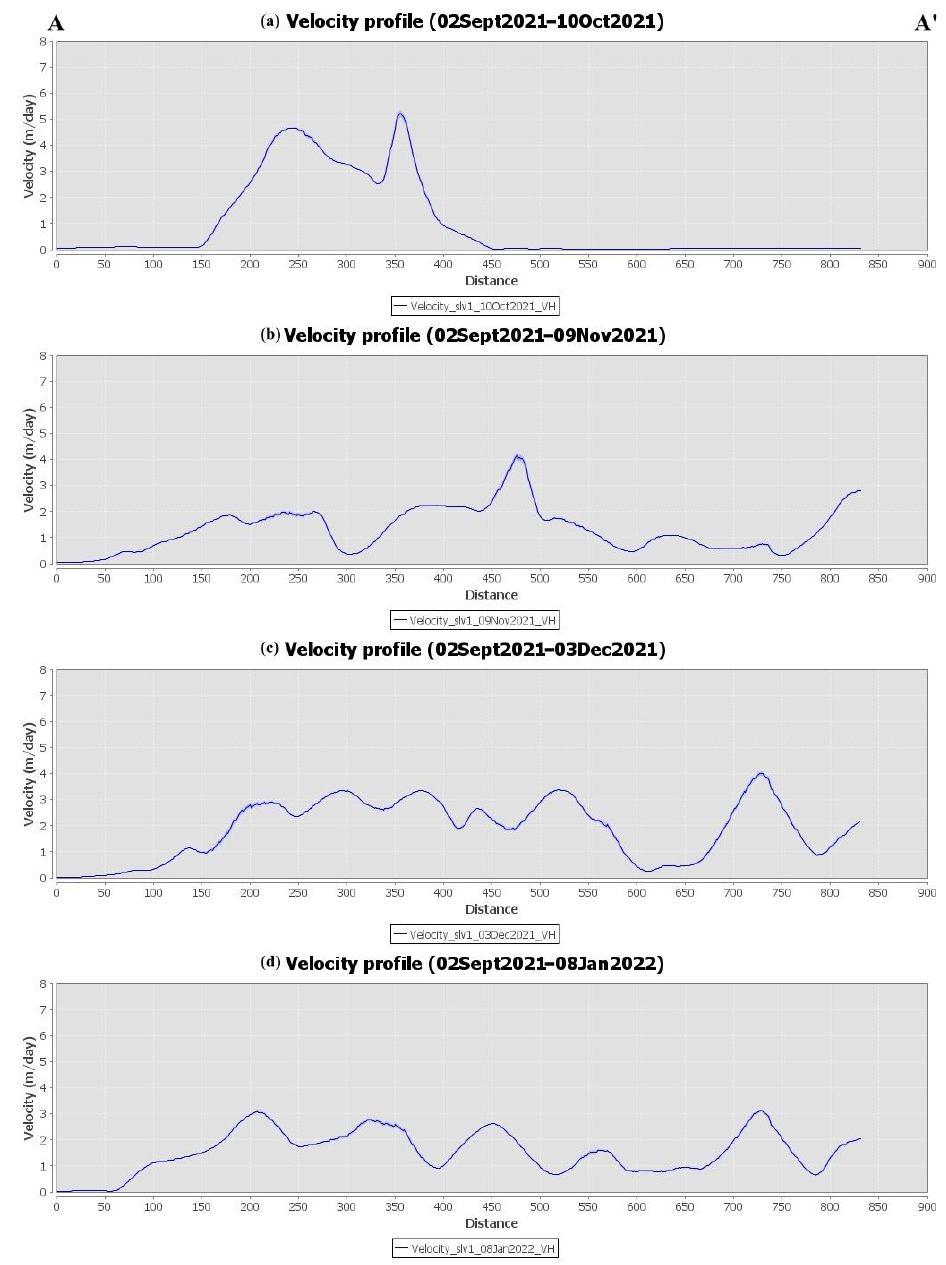
Figure 13. Lava flow velocity profiles of section AA’ throughout the different eruptive phases, obtained by processing the Sentinel-1 descending data through offset tracking.